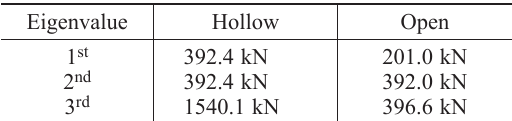
Table 2. The first three eigenvalues Eigenvalue Hollow